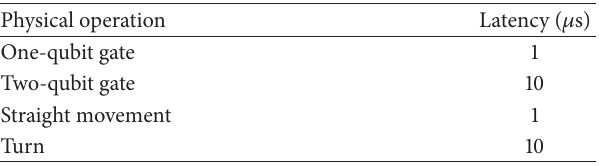
Table 1: Latency values for various physical operations in ion-trap technology